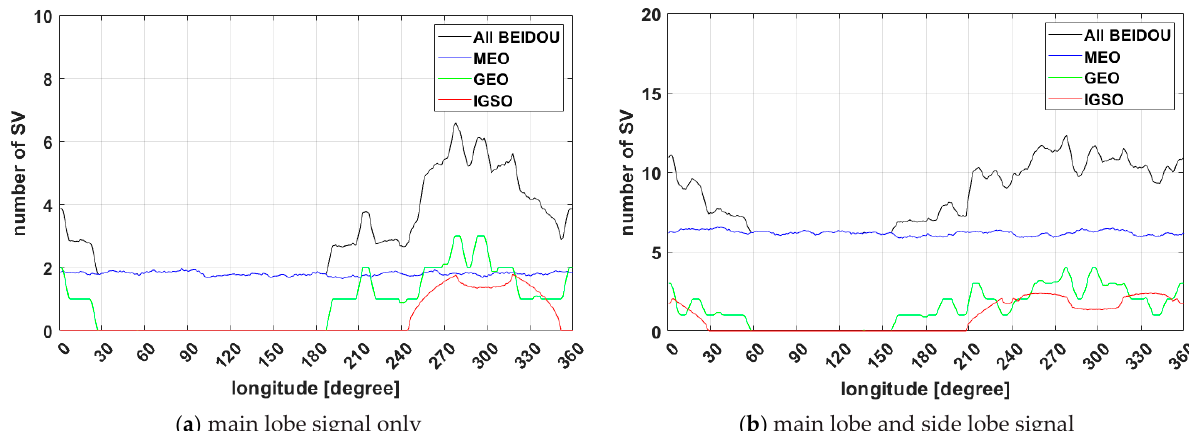
Figure 5. BDS satellite visibility for 24 h in Geostationary orbit with longitude. Next, the environments for GNSS satellite signal reception at the geostationary orbit over the Korean Peninsula (about 128 ◦ E) and the other side of Korea (about 308 ◦ E) were investigated. Figure 6a,b show the results of a simulation of GNSS satellite visibility for 24 h at the geostationary orbit over 128 ◦ E longitude. Because the geostationary orbit over the Korean Peninsula is not a region that can receive non-MEO BDS satellite signals, the visibility of GNSS satellites due to BDS is not improved.